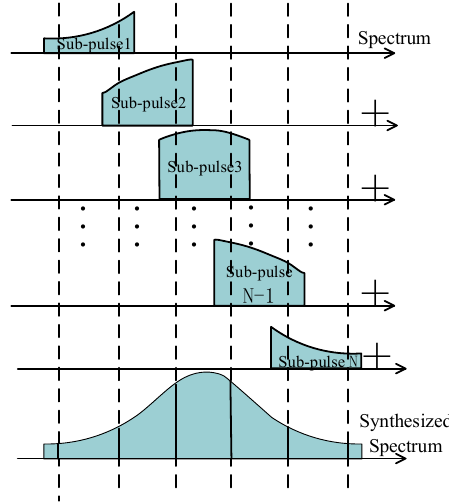
Figure 3. S F FM subpulse splicing. Figure 3. SF FM subpulse